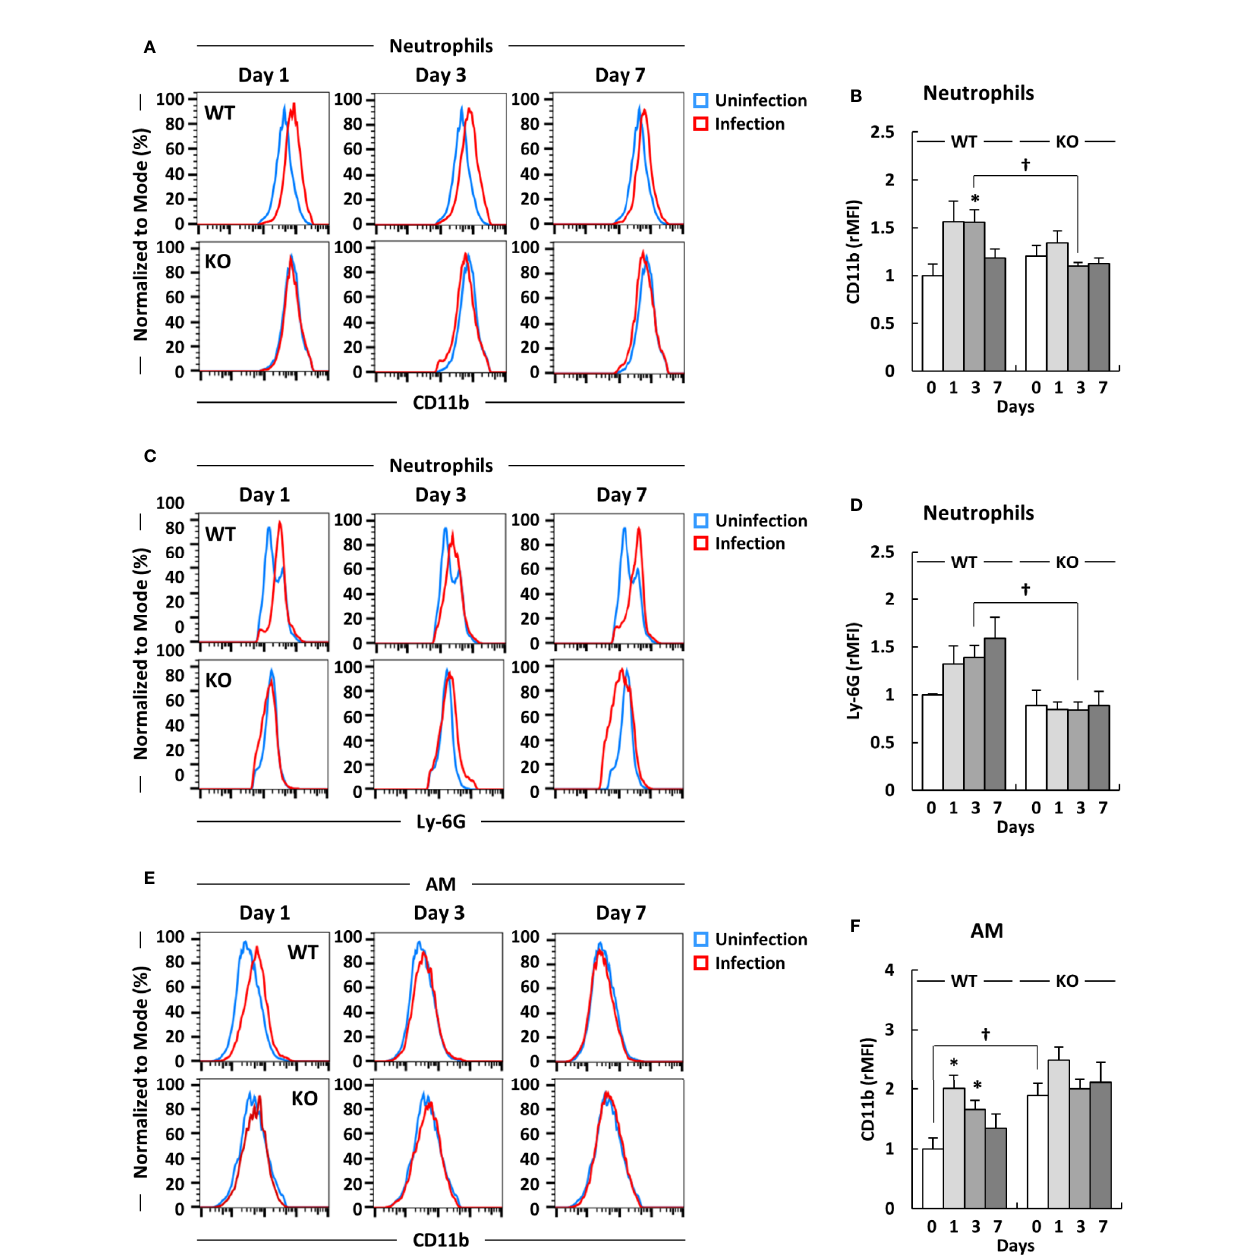
FIGURE 3 | Expression levels of CD11b and Ly-6G on neutrophils, and CD11b on alveolar macrophages (AM) in the lungs of klotho wildtype (WT) and knockout (KO) mice before and after infection with Acinetobacter baumannii . Representative results on (A) CD11b and (C) Ly-6G expression levels on neutrophils and (E) CD11b expression level of alveolar macrophages (AM) in the lungs of uninfected and A. baumannii -infected klotho WT and KO mice. Mean fl uorescence intensity was measured in uninfected (blue line) and infected (red line) klotho mice using fl ow cytometry. Summarized results on the expression levels of (B) CD11b and (D) Ly-6G on neutrophils and (F) that of CD11b on AM in the lungs of klotho WT and KO mice before and after infection with A. baumannii . Bar graph data were compiled from four independent experiments ( n = 16 for WT and n = 15 for KO mice), and represent the mean ± SEM. Asterisks indicate statistically signi fi cant differences (* P < 0.05, before infection vs. after infection, Student ’ s t -test; † P < 0.05, klotho WT mice vs. klotho KO mice, Student ’ s t